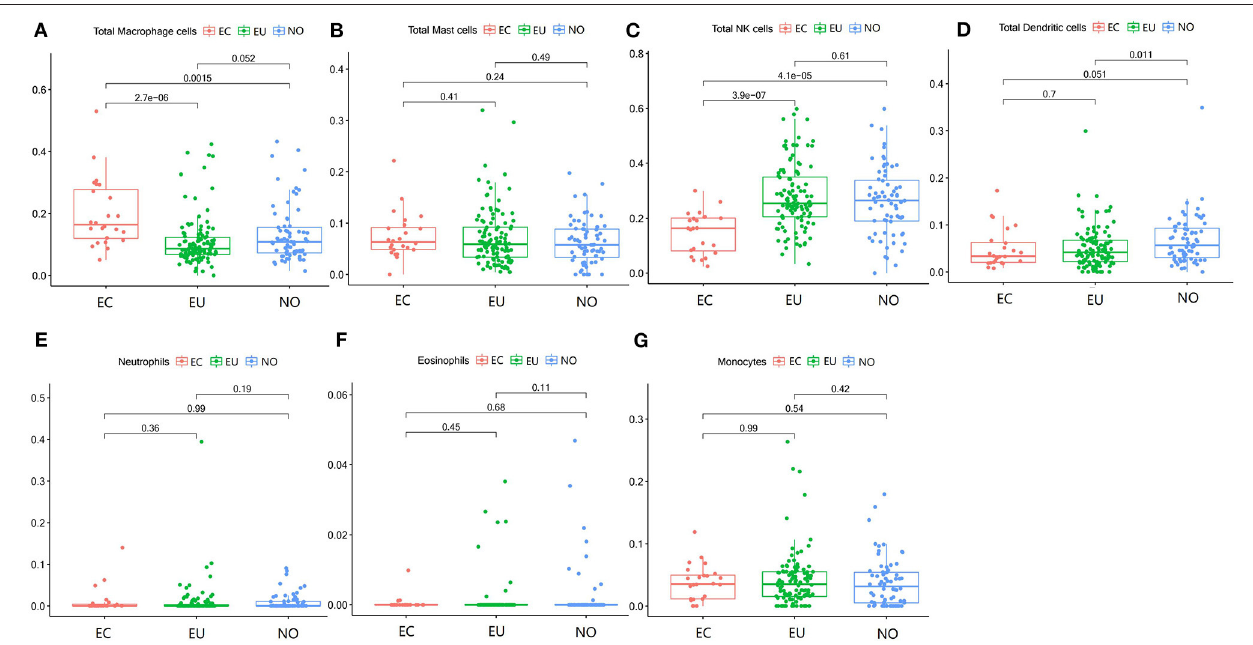
FIGURE 2 | Innate immune cells in EC, EU, and NO. CIBERSORT immune cell fractions were determined for each patient; each dot represents one patient. The upper quartile (P25), median value, lower quartile (P75) after removing datas with large deviation for each cell subset including total macrophages (A) , mast cells (B) , NK cells (C) , dendritic cells (D) , neutrophils (E) , eosinophils (F) , and monocytes (G) were calculated for each patient group and compared using the Kruskal-Wallis test. Y axes represent the composition ratio of each immune cell.